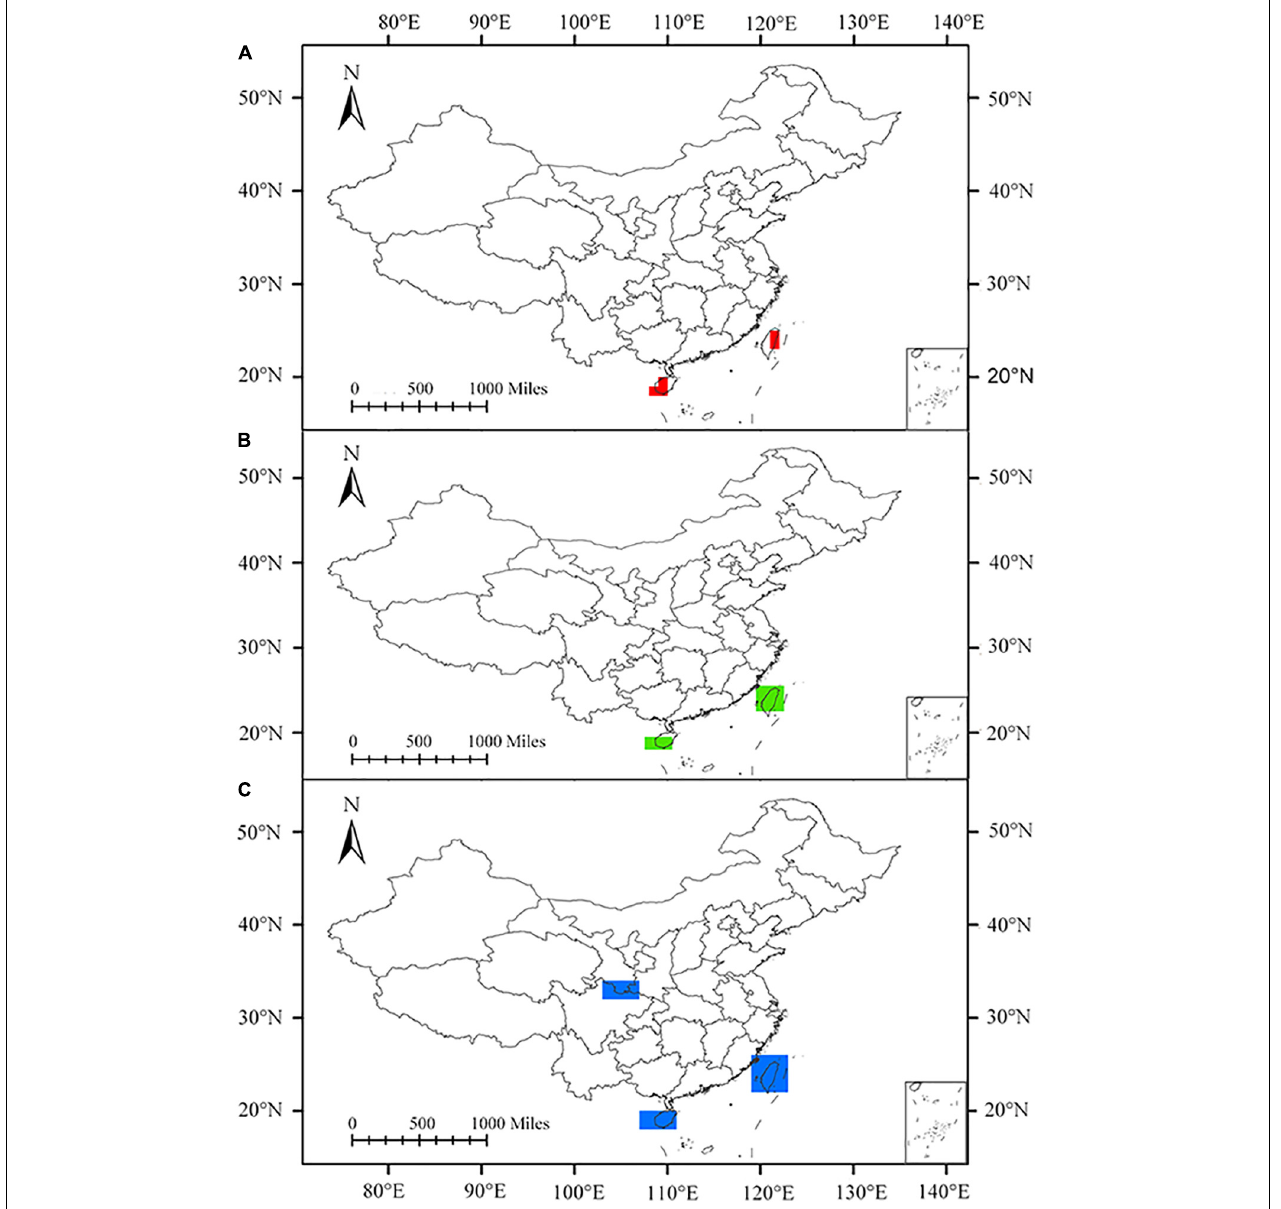
FIGURE 4 | Areas of endemism (AoEs) obtained from planthoppers by parsimony analysis of endemicity (PAE) using three grids in China. (A) 1 ◦ grid, (B) 1.5 ◦ grid, and (C) 2 ◦